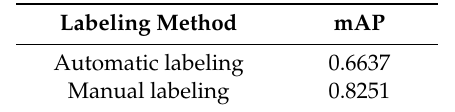
Table 4. Comparison of labeling methods.